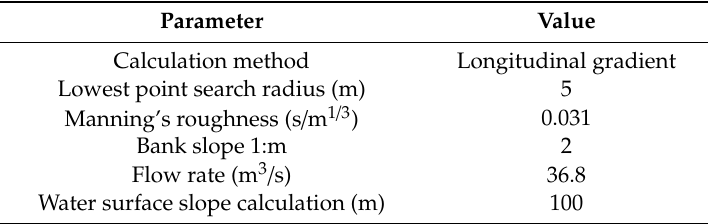
Table 2. The Cross-section Solver ToolBox (CroSolver) software specific settings.